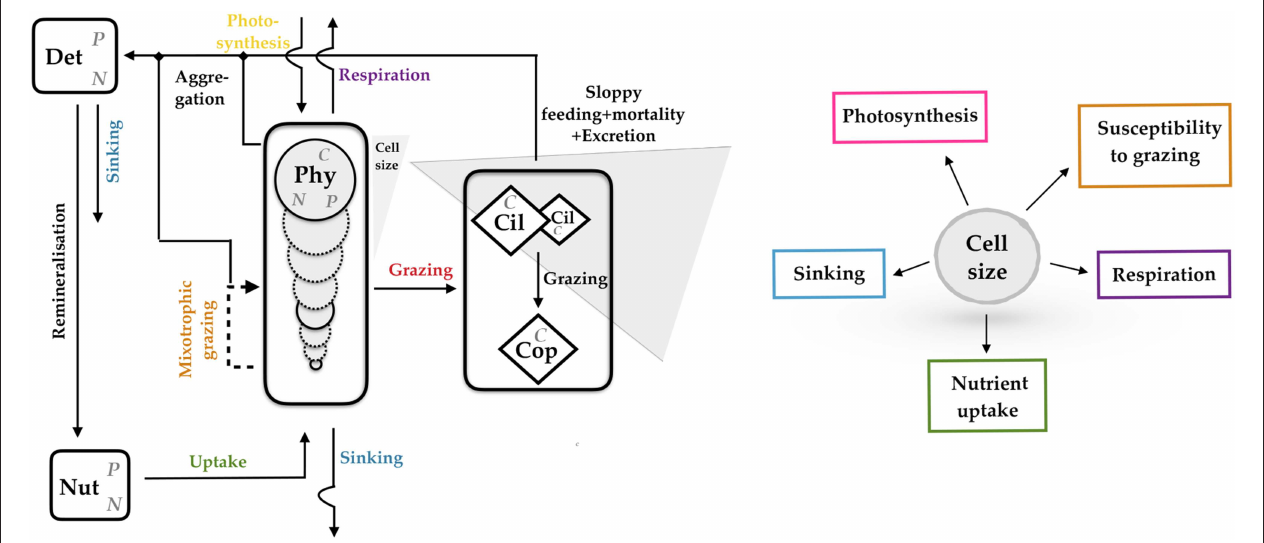
FIGURE 1 | Schematic representation of the size-based multi-species model resolving biomass of phytoplankton species (Phy i with i = 1,..., n ), their internal nutrient quotas, ambient nutrient concentration (Nut), detritus (Det), and zooplankton, further subdivided into small and large ciliates (Cil-S, Cil-L) and copepods (Cop). Mass flows between compartments or exchanged with the environment are given as arrows. Most of these flows depend on cell size as conceptualized in the right inlay graph. N, Nitrogen; P, Phosphorous; C,